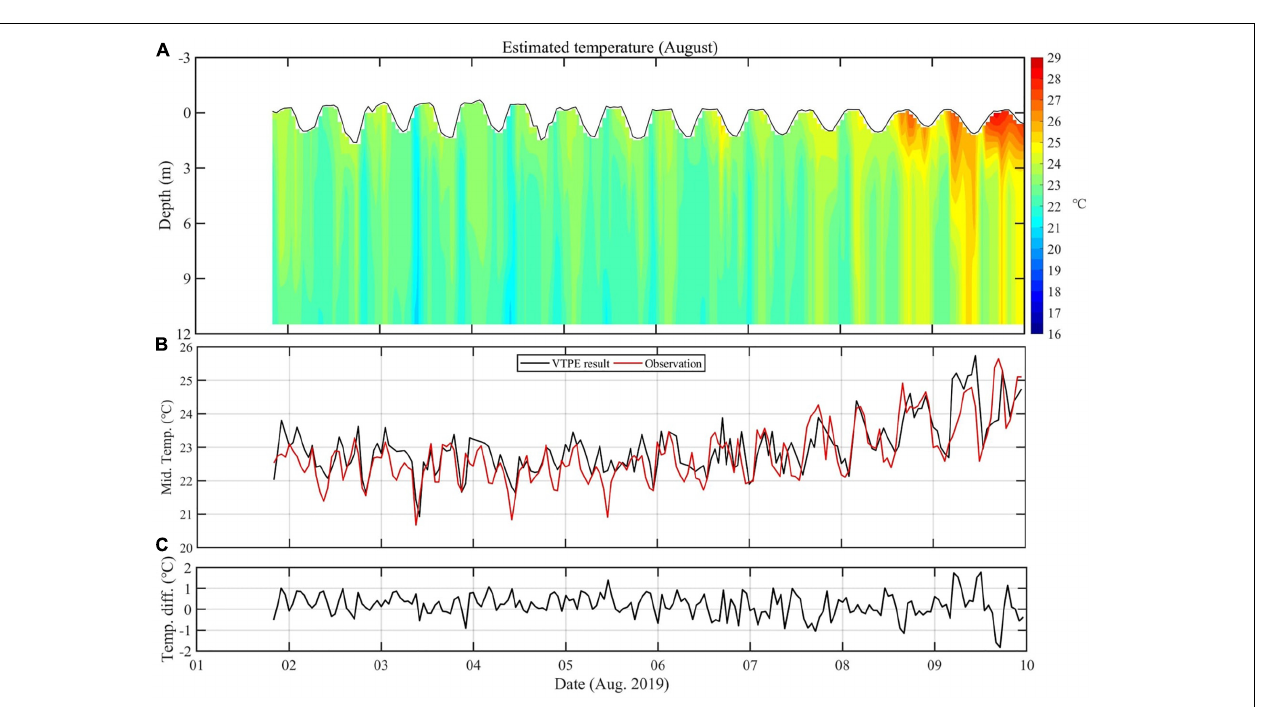
FIGURE 7 | (A) Timeseries of temperature profiles estimated from the VTPE method using the field observation data gathered in August 2019. (B) Comparison of middle-layer temperatures between the estimated and the in situ measurement at a site between the two CAT stations. (C) Difference of the two timeseries of temperatures shown in (B)